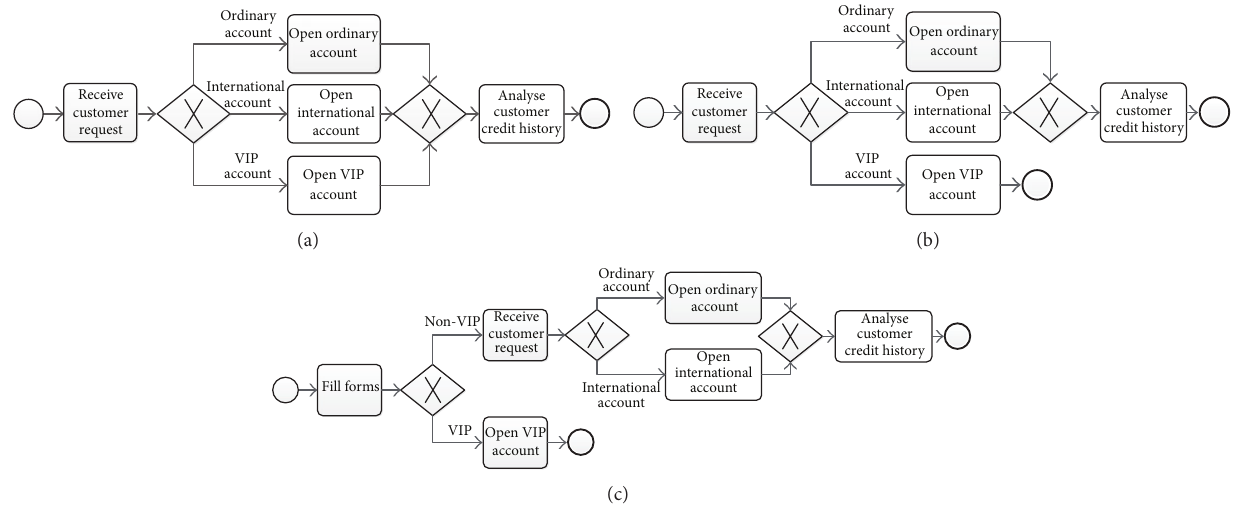
Figure 1: Three variants of a business process for opening bank accounts.